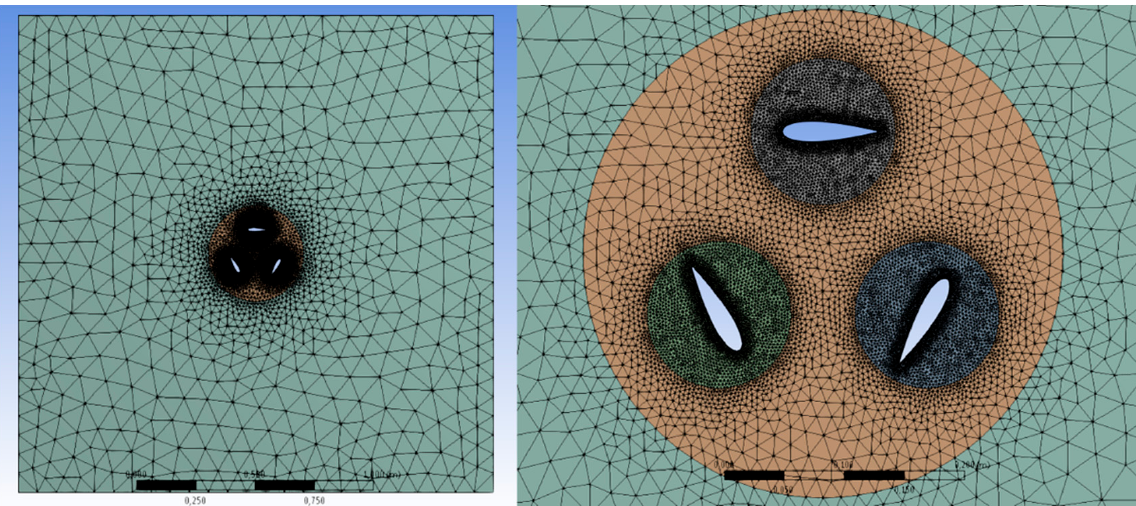
Figure 7. Mesh of the model. The results of the simulation of the velocities are shown in Figure 8a,b.